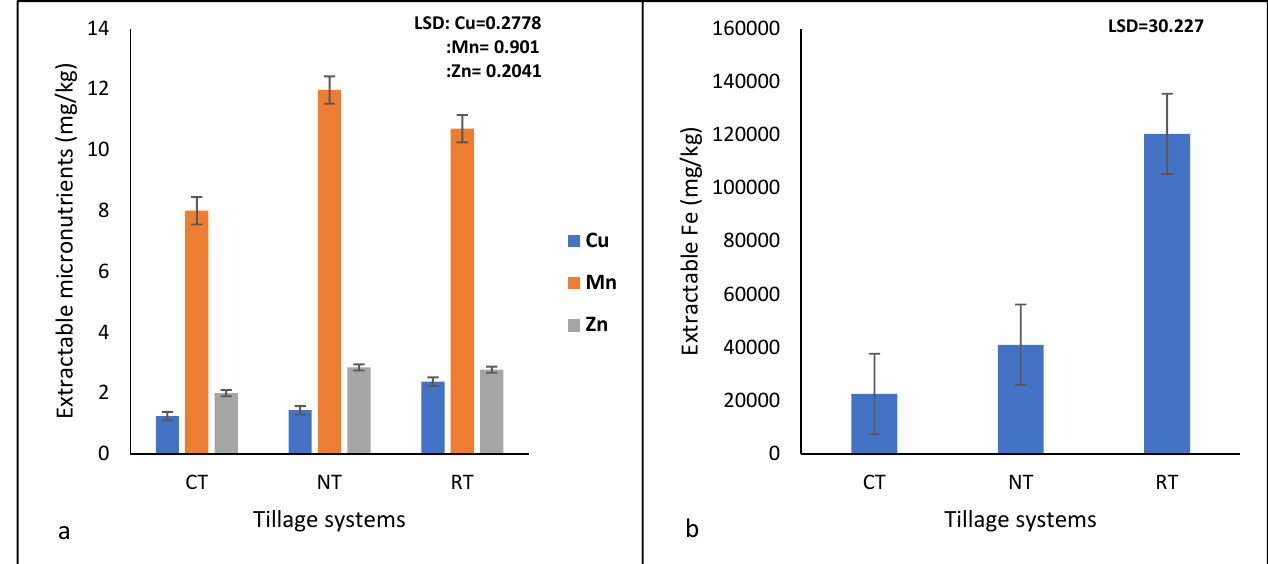
Figure 8. Extractable micronutrients [(copper (Cu), manganese (Mn), zinc (Zn) ( a ) and iron (Fe) ( b )] in three different tillage treatments of no-till (NT), rotational tillage (RT), and conventional tillage (CT) after 17 years of trial establishment.